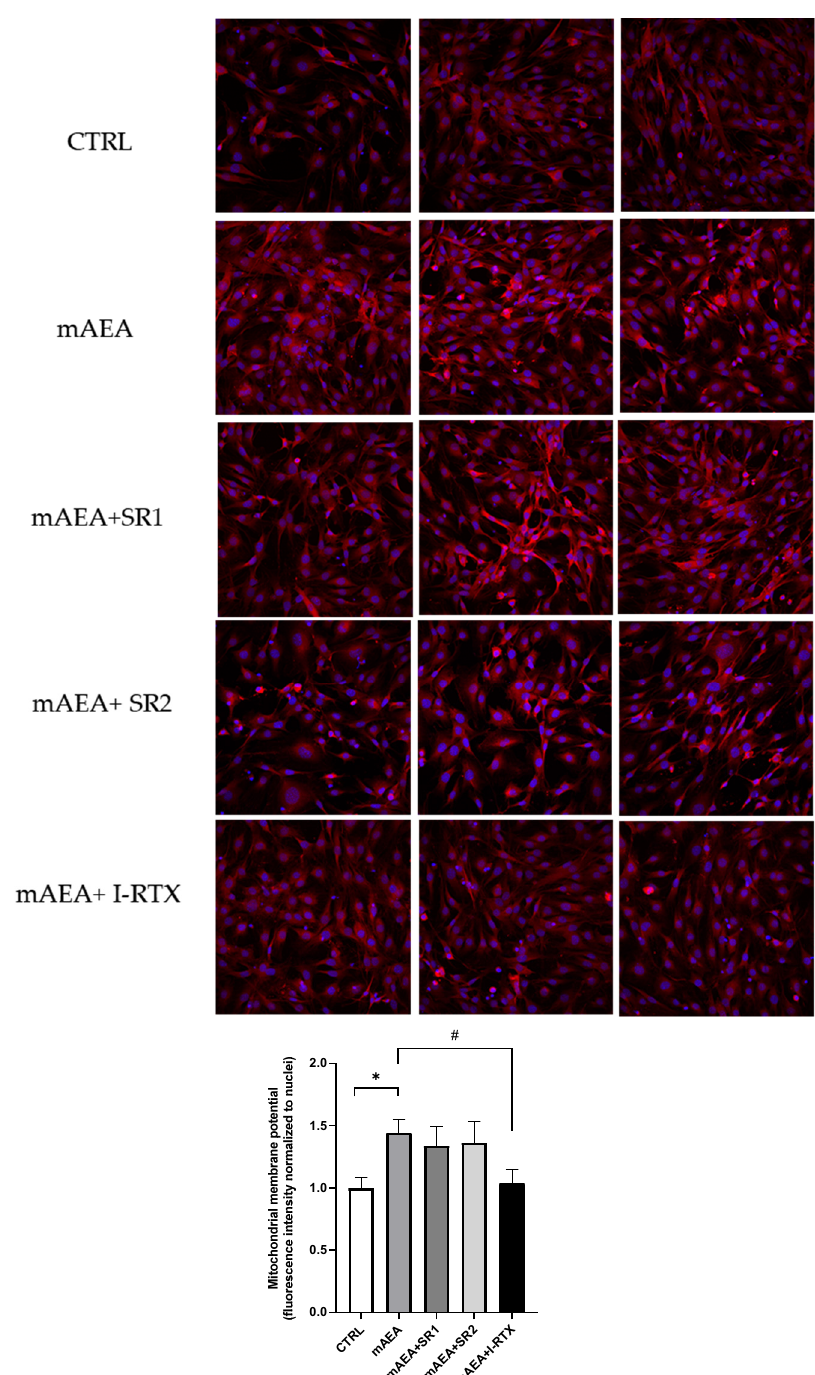
Figure 10. Role of eCB receptors on mitochondrial activity induced by 5 µ M mAEA in C2C12 myoblasts. Confluent serum-starved C2C12 myoblasts were treated with 5 µ M mAEA for 24 h in the presence of eCB receptor antagonists (SR1, SR2 or I-RTX). The fluorescence intensity of Mitotracker Red CMX-Ros (Ex/Em: 579/599) was normalized to cell number, and data are reported as mean ± SEM of six field per condition in each of the three independent experiments. Statistical analysis was performed by ONE-WAY ANOVA [* p < 0.05] and TWO-WAY ANOVA [# p < 0.05] followed by Bonferroni post-hoc test.